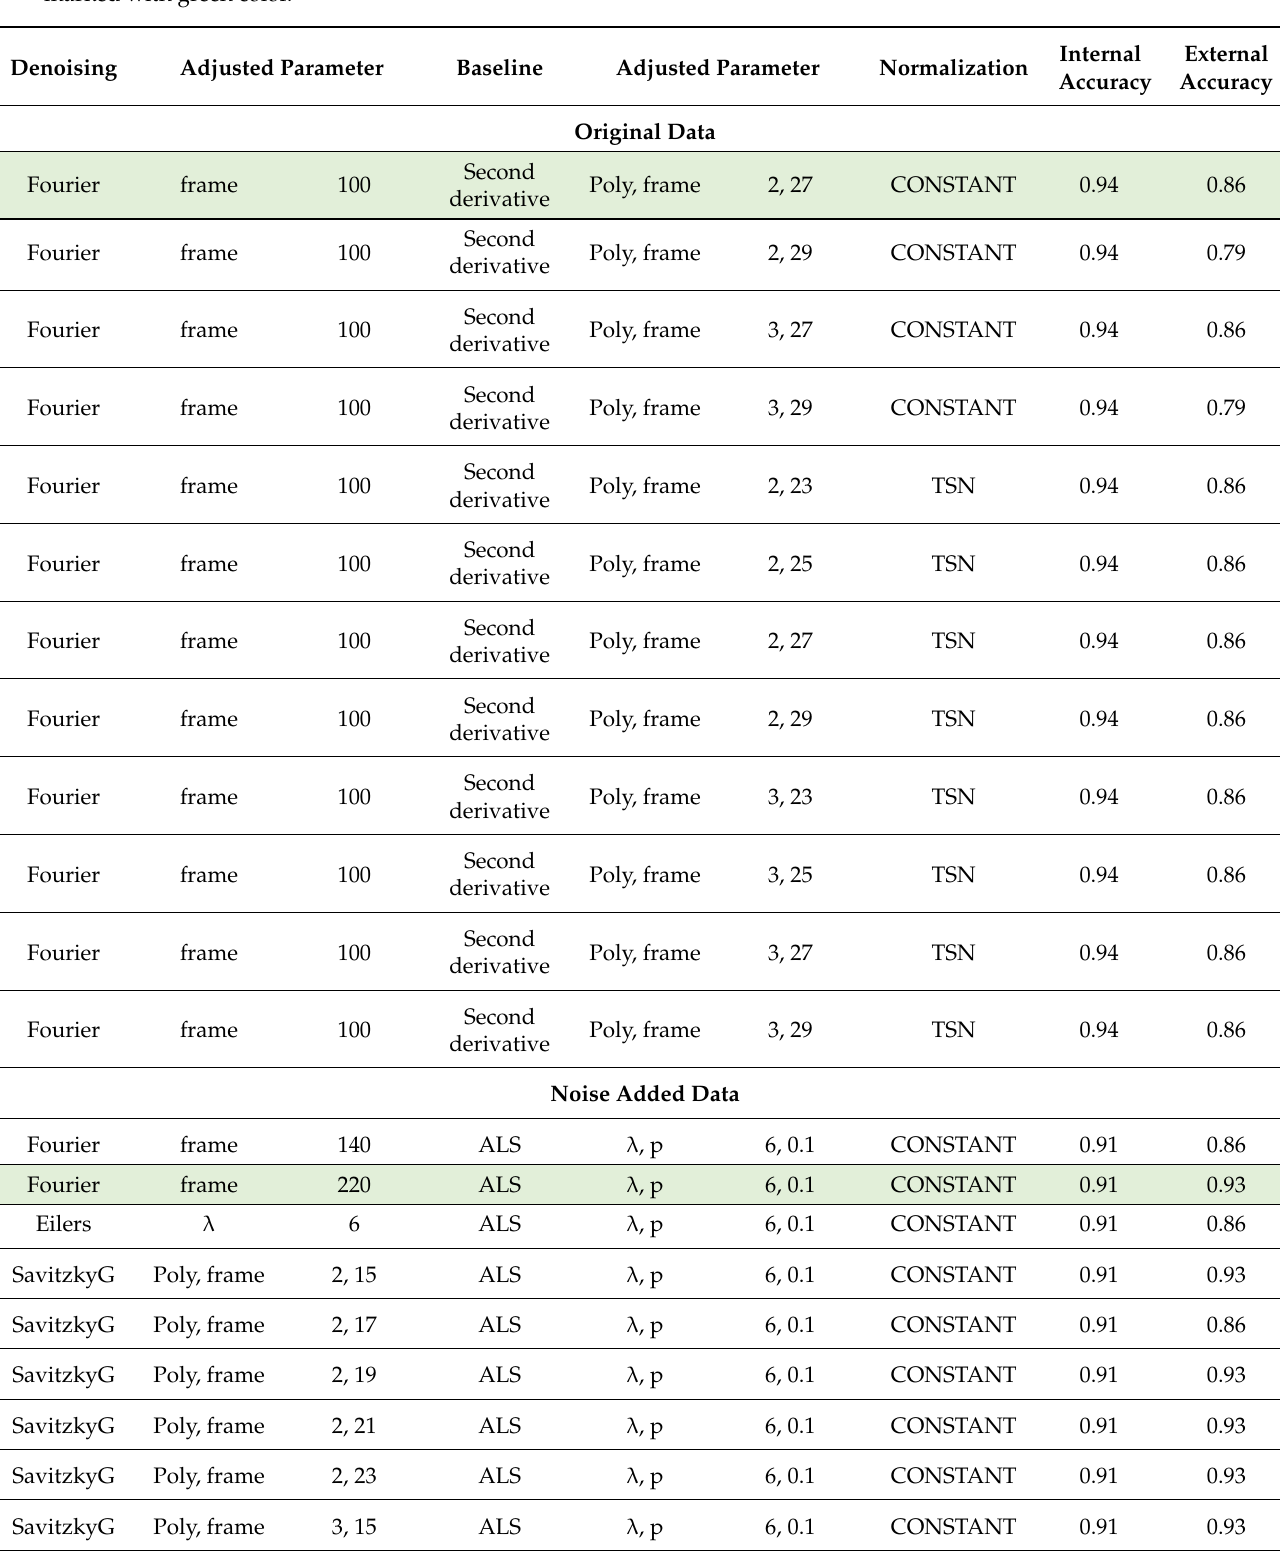
Table 1. The best combination of methods gave very high internal accuracy with the smallest reasonable LVs (marked with the red circle in the left panel in Figure 3). Methods giving the best external validation values for original and raw data were marked with green